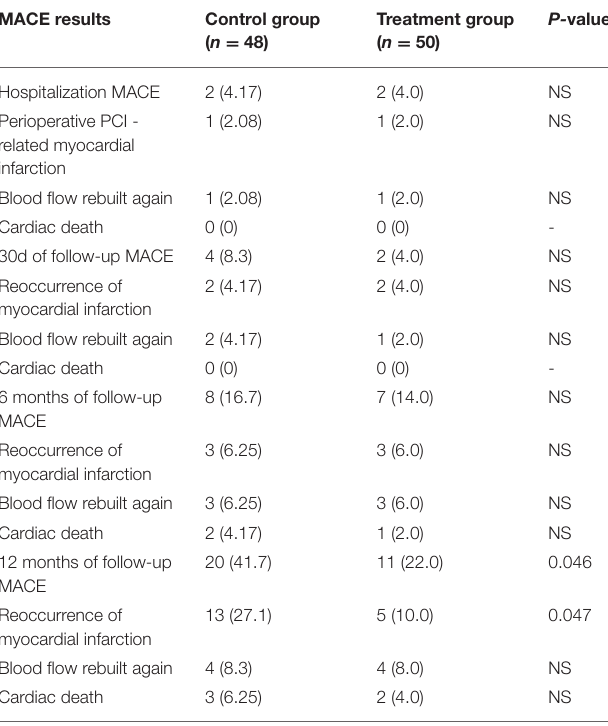
TABLE 3 | Comparison of MACE results between the two groups during 12-month follow-up [cases (%)]. MACE